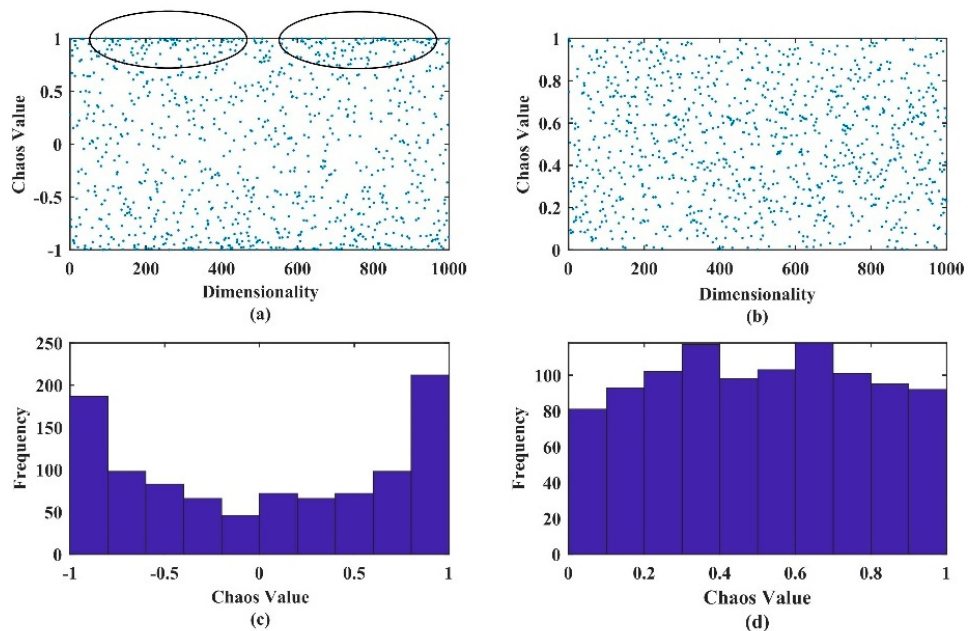
Figure 1. ( a ) Dimensional distribution map of the solutions generated by the original sine mapping. The circle in ( a ) is the focused observation area, demonstrating the boundary aggregation phenomenon; ( b ) dimensional distribution map of the solutions generated by the improved sine mapping; ( c ) dimensional distribution histogram of the solutions generated by the original sine mapping; ( d ) dimensional distribution histogram of the solutions generated by the improved Sine mapping.